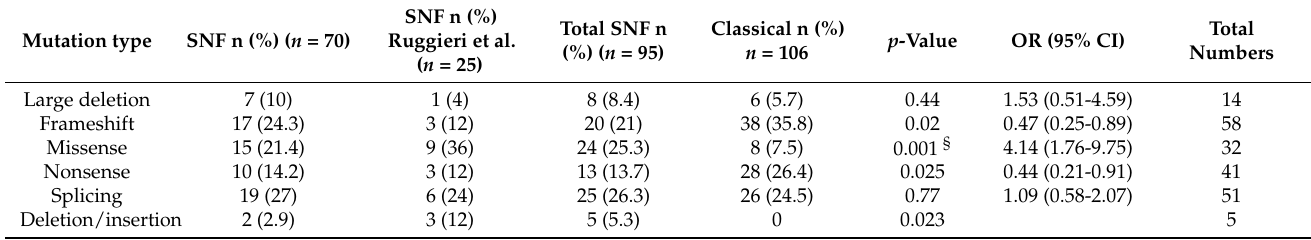
Table 7. Distribution of the NF1 mutation types between the SNF and classical groups, including cases reported by Ruggieri et al.